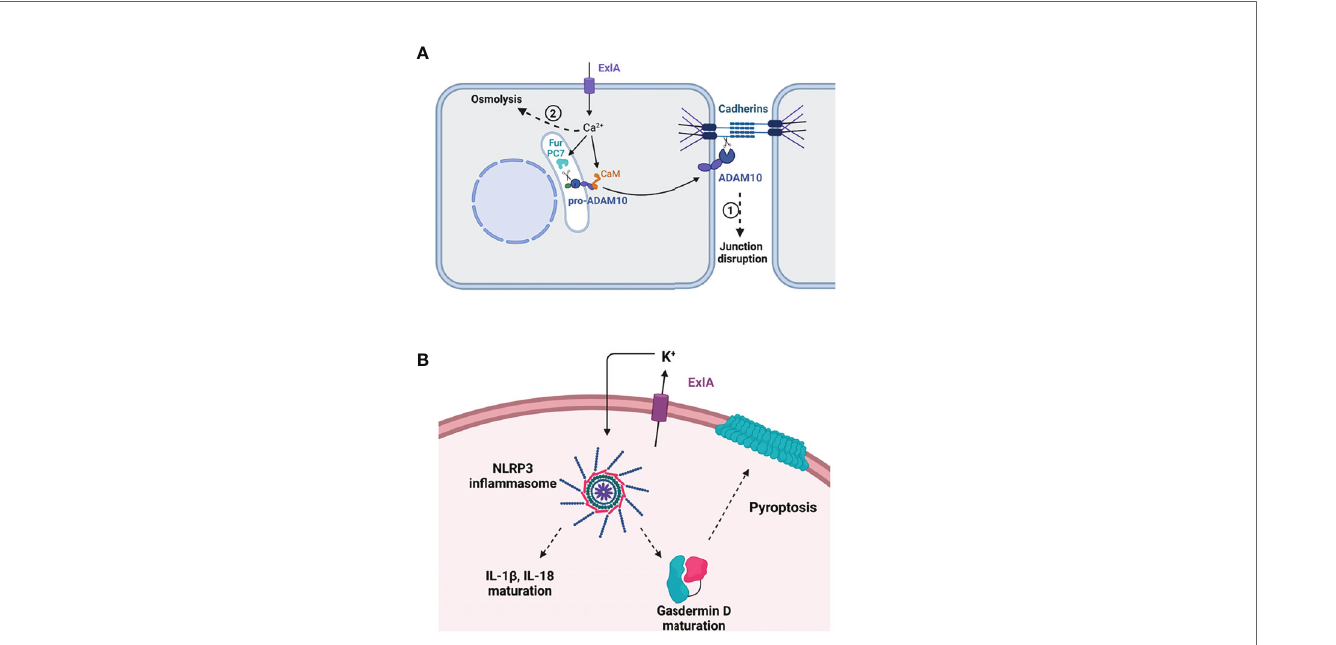
FIGURE 2 | Effect of ExlA pore formation in host cells. (A) Effect in epithelial and endothelial cells. Pore formation induces massive Ca2+ in fl ux, which activates two processes. In the fi rst process, Ca2+ binds to calmodulin (CaM), releasing calmodulin from pro-ADAM10, and activates two convertases, furin (Fur) and PC7, which excise the ADAM10 prodomain. Mature ADAM10 is then exported to the plasma membrane where it cleaves the cadherin ectodomain, leading to junction disruption. In the second phase, cells die from osmolysis owing to ion imbalance. (B) In macrophages, ExlA induces cell death by pyroptosis. K+ ef fl ux through ExlA pores induces the assembly of the NLRP3 in fl ammasome, thereby activating caspase-1. Caspase-1 excises IL-1 b and IL-18 prodomains and cleaves pro-gasdermin D. Mature gasdermin D oligomerizes and oligomers form a large pore in the plasma membrane, allowing the release of in fl ammatory cytokines. (A, B) Created with